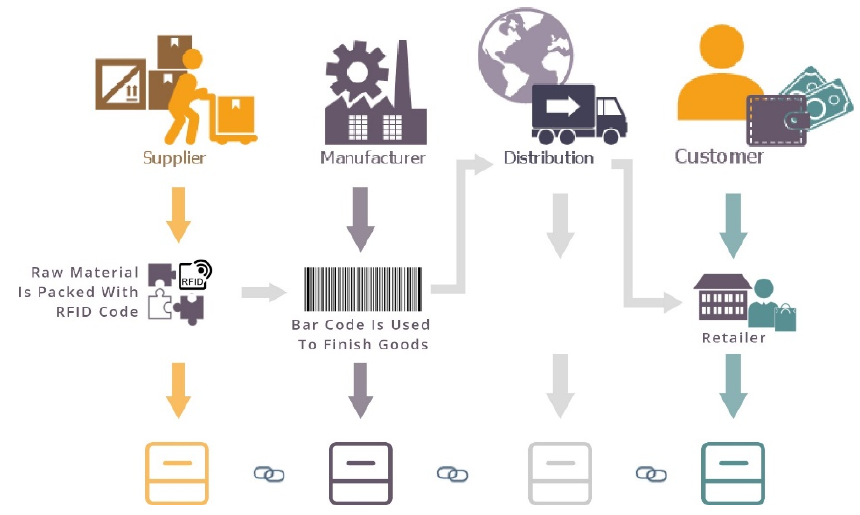
Figure 8. Blockchain in a supply chain